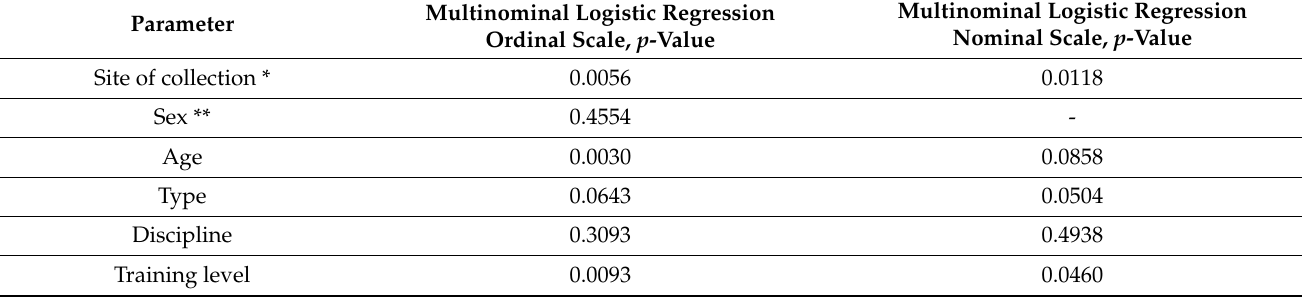
Table 5. Results of the multivariate analysis of the Body Condition Score and predictors.